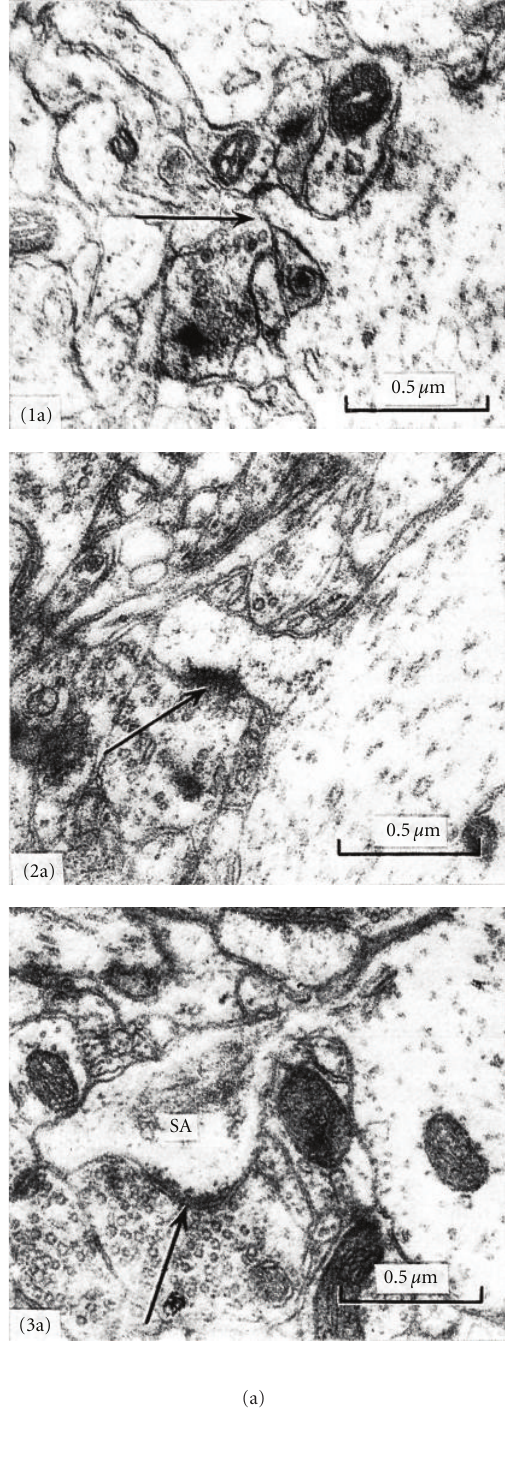
Figure 5: Development of dendritic spines, visual cortex, 19-day-old mouse according to Freire [16, Figures 1, 2, and 3], using serial section electron microscopy. (1a) and (1b) show two medial sections through a dendritic spine in phase 1 of development, the synaptic zone is not developed, but it is contacted by one axon (arrows), no cistern (sacs) of the spine apparatus is present, 19-day-old mouse reared in the dark. (2a) and (2b) show two medial sections through a phase 2 spine, a synaptic zone has appeared (arrows) but is not sacs of the spine apparatus, 19-day-old normal mouse. (3a) and (3b) show two medial sections through a phase 3 dendritic spine with cisterns in its spine apparatus (SA), and a well-developed synaptic zone